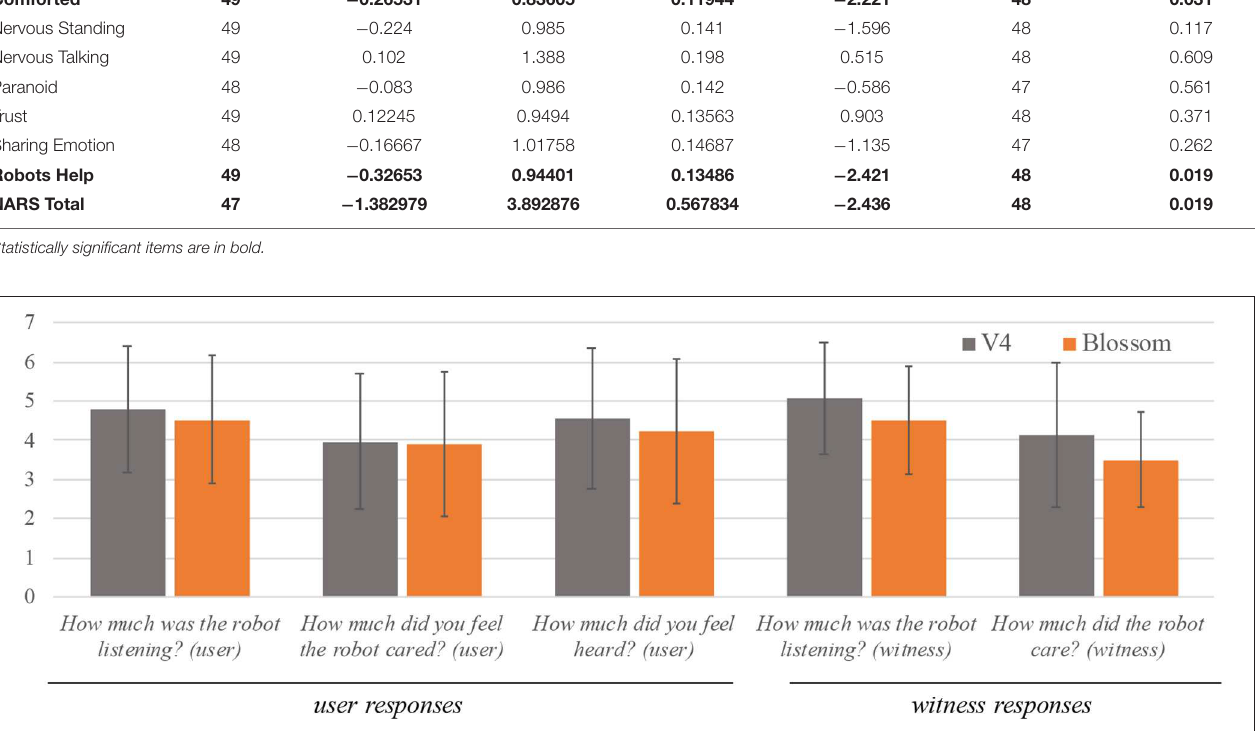
FIGURE 5 | Post-interaction survey responses comparing EMAR V4 and blossom.